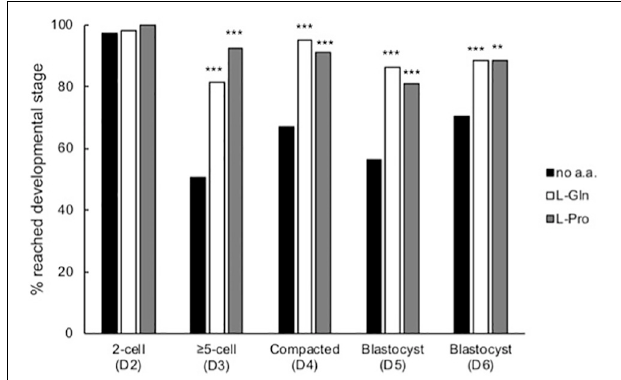
FIGURE 5 | Effect of timing of addition of L-Pro on development of mouse embryos cultured in isosmotic (270 mOsm/kg) medium at LD. Zygotes (20–22 h post-hCG) were cultured for 5 days in the absence of amino acids (no a.a. [1C to blastocyst]) or in the presence of 400 µ M L-Pro (i) for the first 24 h of culture (i.e., from the 1-cell (1C) to 2-cell (2C) stages) and then transferred to no a.a. medium for the remainder of the culture period (L-Pro [1C to 2C only]); (ii) for the full 5 days (L-Pro [1C to blastocyst]); or (iii) from the 2-cell stage onward following 24 h culture in no a.a. (L-Pro [2C to blastocyst]). The percentage of zygotes that developed to the designated stages over the 5 days was recorded. D indicates the day of development; n = number of individual embryos that were analyzed from at least four independent biological replicates. * P < 0.05; ** P < 0.01; *** P < 0.001 indicates significant differences from the no amino acid control at each time point, analyzed by Chi-squared